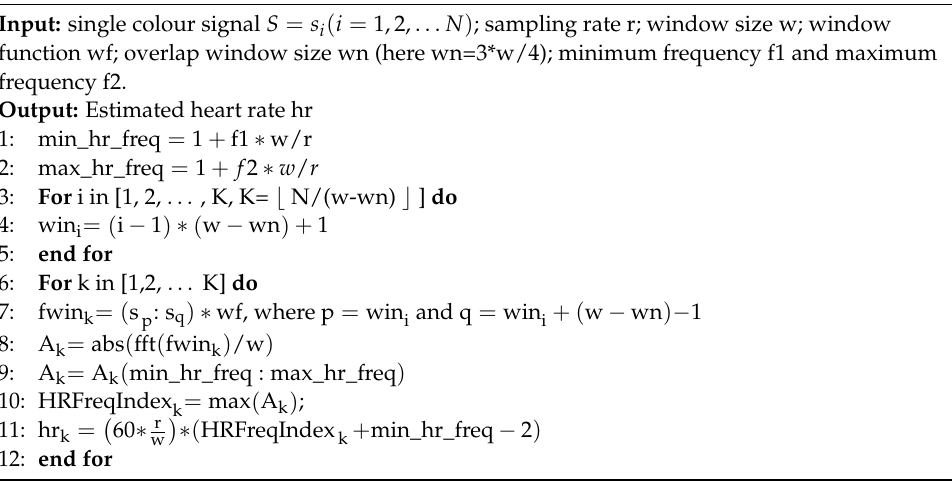
Algorithms 1 Computation details of HR